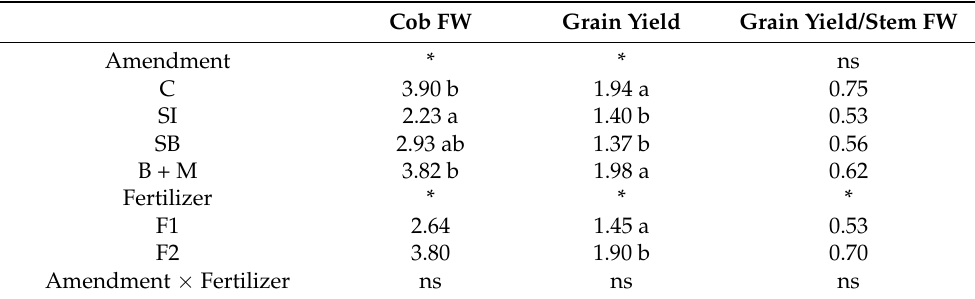
Table 5. Average fresh weight (FW) of cobs (t ha − 1 ) at harvest, grain yield (t ha − 1 ) and grain yield in relation to the stem fresh weight for each of the amendment (none (C), rice straw buried (SB), rice straw incorporated (SI) and biochar plus manure (B + M)) and fertilizer (F1 = 90N; 60P2O5; 30K2O; F2 = 1.5F1) treatments tested in experiment